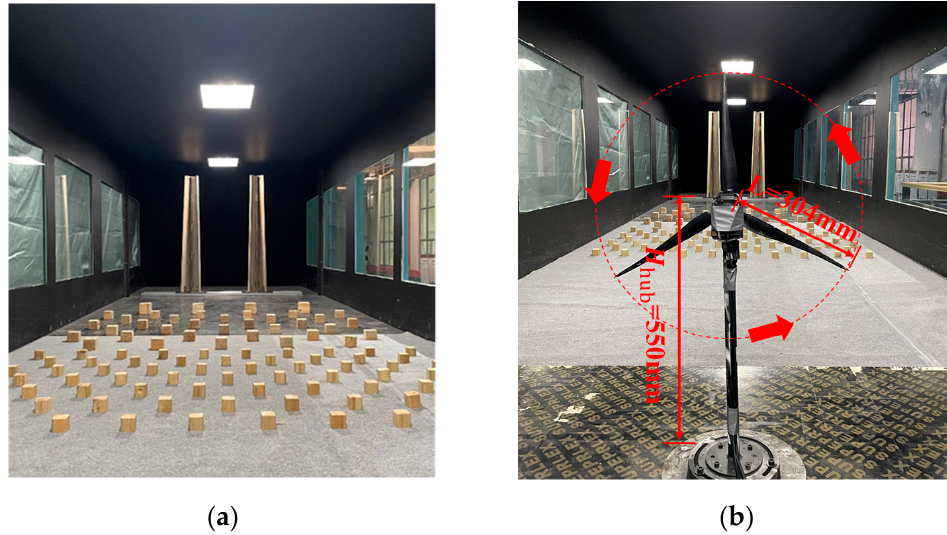
Table 1. Experimental scenarios in this study.